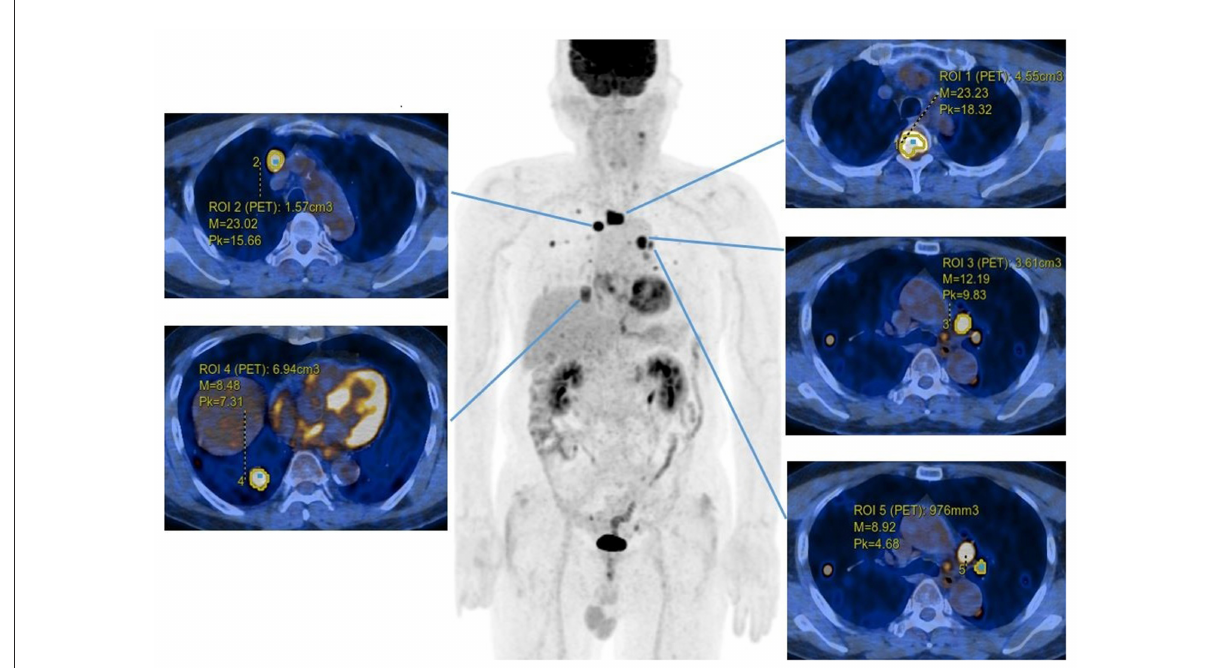
FIGURE1 Representative image of lesion measurement. PET parameters were measured in a 71-year-old male patient with multiple metastatic lesions in both lungs, mediastinal lymph nodes, and a bone. The margins within the volume of interests were automatically created according to the 40% threshold of SUV max . MTV, SUV max , and SUV peak are displayed in the axial fusion